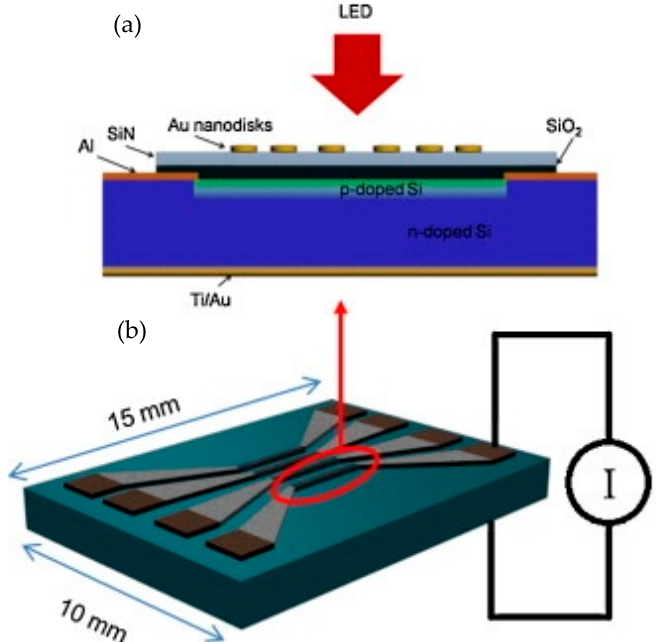
Figure 5. Schematic of the device detailed in Mazzotta et al. [68]. ( a ) Cross section of the photodiode (PD) with integrated gold nanodiscs. ( b ) Schematic of the sensor chip having four PDs with dimensions of 2 mm × 0.14 mm. Two PDs had gold nanodiscs fabricated on top while the other two PDs were used as a reference. The total size of the sensor chip is 15 mm × 10 mm. Reprinted with permission from [68]. Copyright © Elsevier (2010).